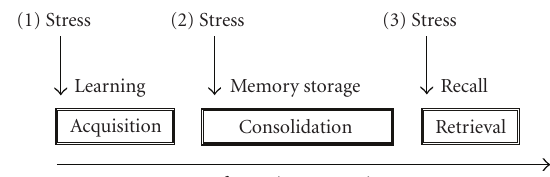
Figure 1: Diagram depicting the relevance of specifying timing of stress with regards to di ff erent memory phases. If stress (1) is given before learning (acquisition of information), it can potentially af- fect all cognitive phases involved in memory function; that is, ac- quisition, consolidation, and/or retrieval. However, if acquisition is already a ff ected, that would be the main conclusion to extract from the particular experiment. If stress (2) is experienced after learn- ing, any e ff ect observed in retention could now be due to an impact of stress on either consolidation or retrieval, but any e ff ects on ac- quisition can be discarded. However, e ff ective treatments given at this time point normally disrupt the process of memory storage, in- stead of retrieval, which can be further tested by given the treatment at later time points (at a di ff erent—or outside the—consolidation phase) and assess whether recall is then also a ff ected. If stress (3) is delivered before the recall test, it should just normally a ff ect the re- trieval processes. However, a note of caution should be mentioned depending on how close the retention test is applied with regards to training, since consolidation mechanisms are increasingly rec- ognized to last longer than previously hypothesized and, therefore, this type of manipulation could influence both consolidation and retrieval processes. Research on this field should take into account this complexity and apply the necessary controls to ascertain which phase and mechanisms of the information processing is a ff ected by the stress procedure under